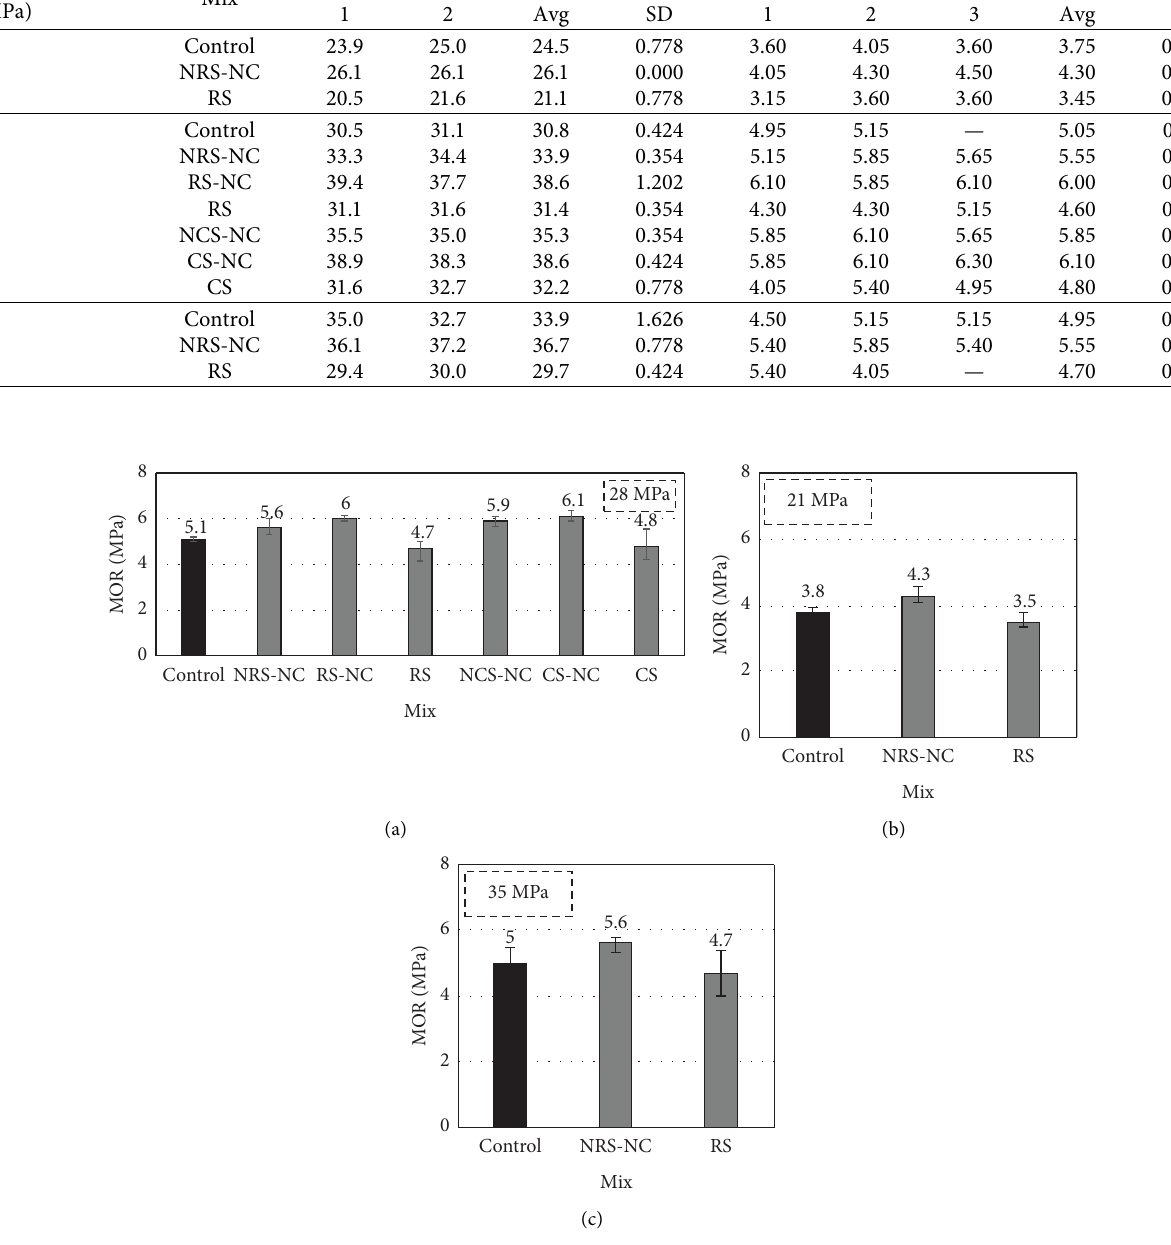
Figure 8: Modulus of rupture (MOR) results (a) for 28MPa, (b) for 21MPa, and (c) for 35MPa concrete. Table 5. Similar to compressive strength results, it could be observed from Figure 8(a) that for 28 MPa concrete, fexural strength at 28 days for concretes mixes NRS-NC, RS-NC, NCS-NC, and CS-NC are higher by 9.8%, 17.6%, 15.7%, and 19.6%, respectively, than that of control mix incorporating the LS. Similar improvements due to the enhanced gradation of river sands by incorporating the quarry dust are observed in the 28 days compressive strength for 21 and 35 MPa concretes as shown in Figures 8(b) and 8(c), respectively.